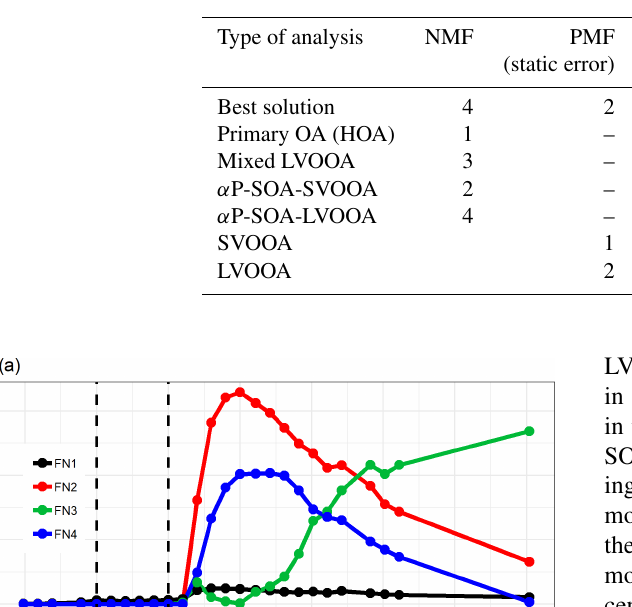
Table 2. Summary of the results for particle-phase composition data. Best solution refers to the number of factors or clusters.